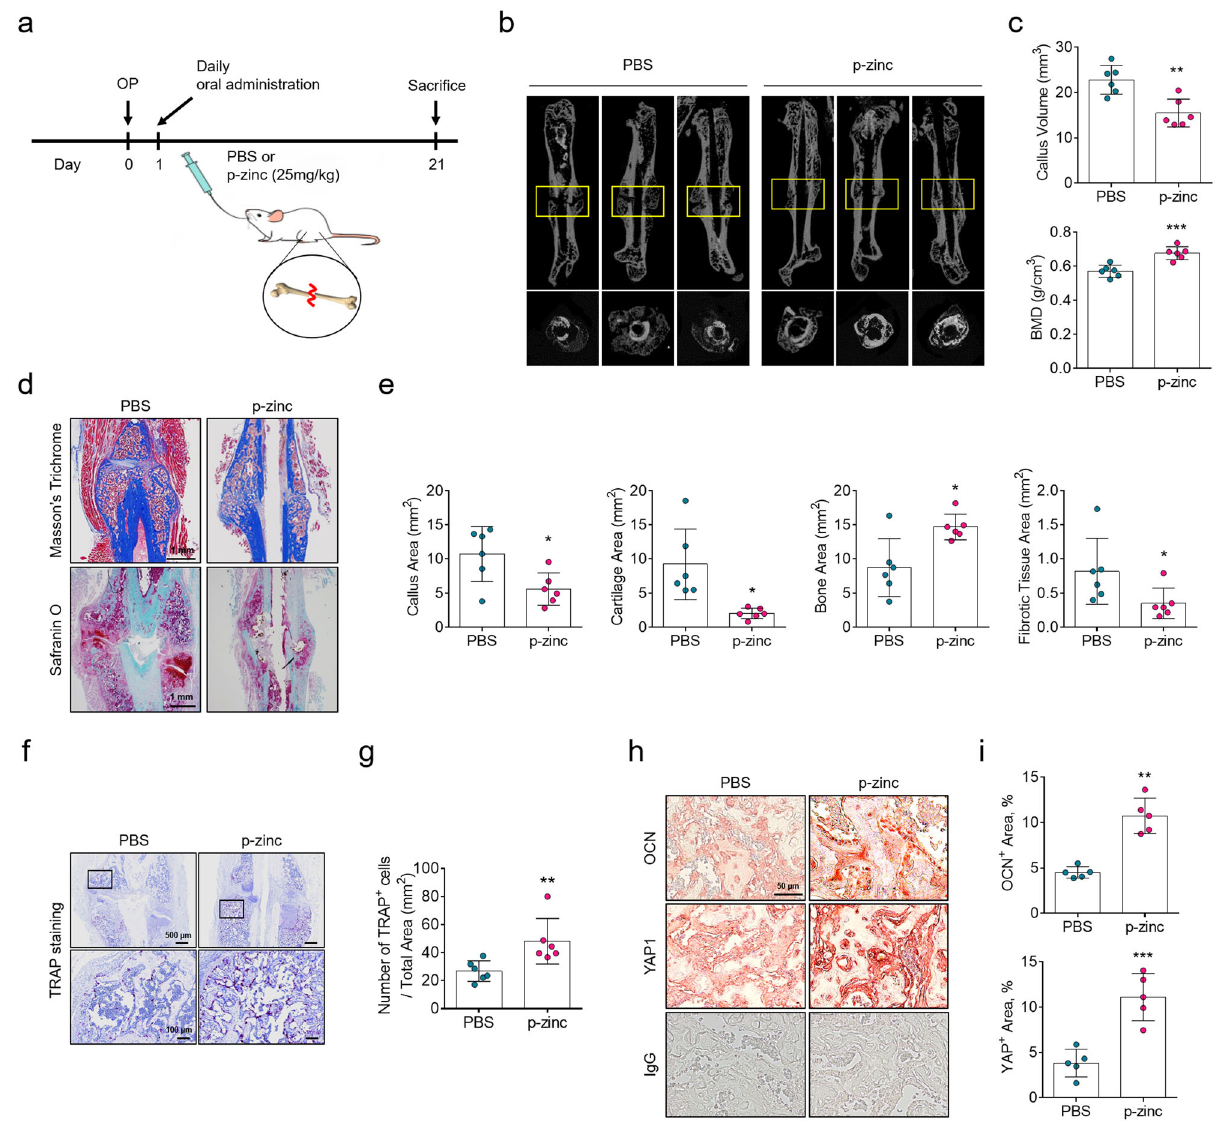
Fig. 5 Micro-CT analysis in a mouse femoral fracture model and the effects of polaprezinc. a Scheme of the animal study. PBS or polaprezinc (25 mg/kg) was orally administered daily after fracture. Male ICR mice at 8 weeks of age were euthanized at 21 days post-procedure ( n = 6). Femoral samples from each group were collected and subjected to μ CT analysis to examine callus formation. b Representative μ CT images of fracture calluses at 3 weeks post- closed femur fracture. c Callus volume and bone mineral density (BMD) were quanti fi ed using μ CT analysis. d Representative images of the fracture callus stained with safranin O. Scale bar = 1 mm. e Quanti fi cation of callus area, cartilage area, bone area and fi brotic tissue area. f Representative images of the fracture callus stained with TRAP. Scale bar = 500 or 100 μ m. g Quanti fi cation of TRAP-positive cells from total cell population per total area (mm 2 ) in histological sections. h Representative images of the fracture callus stained with anti-osteocalcin or anti-YAP1 antibody. Scale bar = 50 μ m. i Quanti fi cation of OCN or YAP-positive area by ImageJ